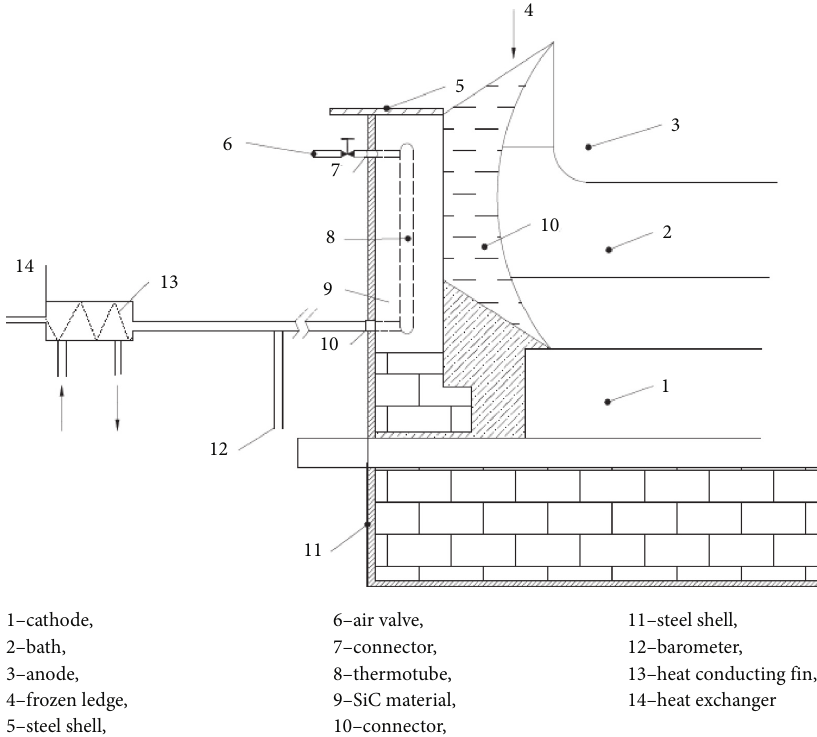
Figure 1: A type of heat-exchanging aluminum reduction cell developed by Hydro Aluminum [6].